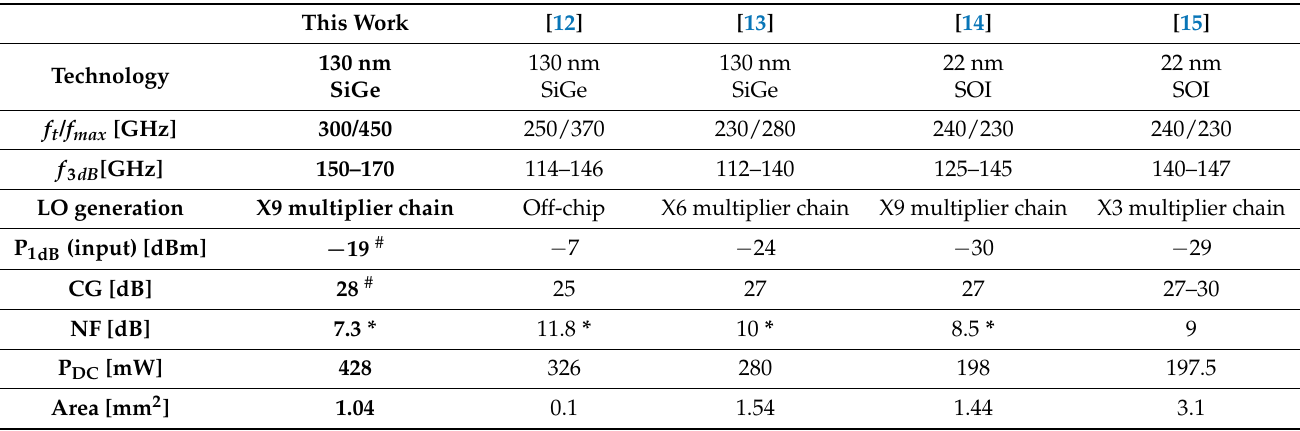
Table 1. Performance comparison and results summary.